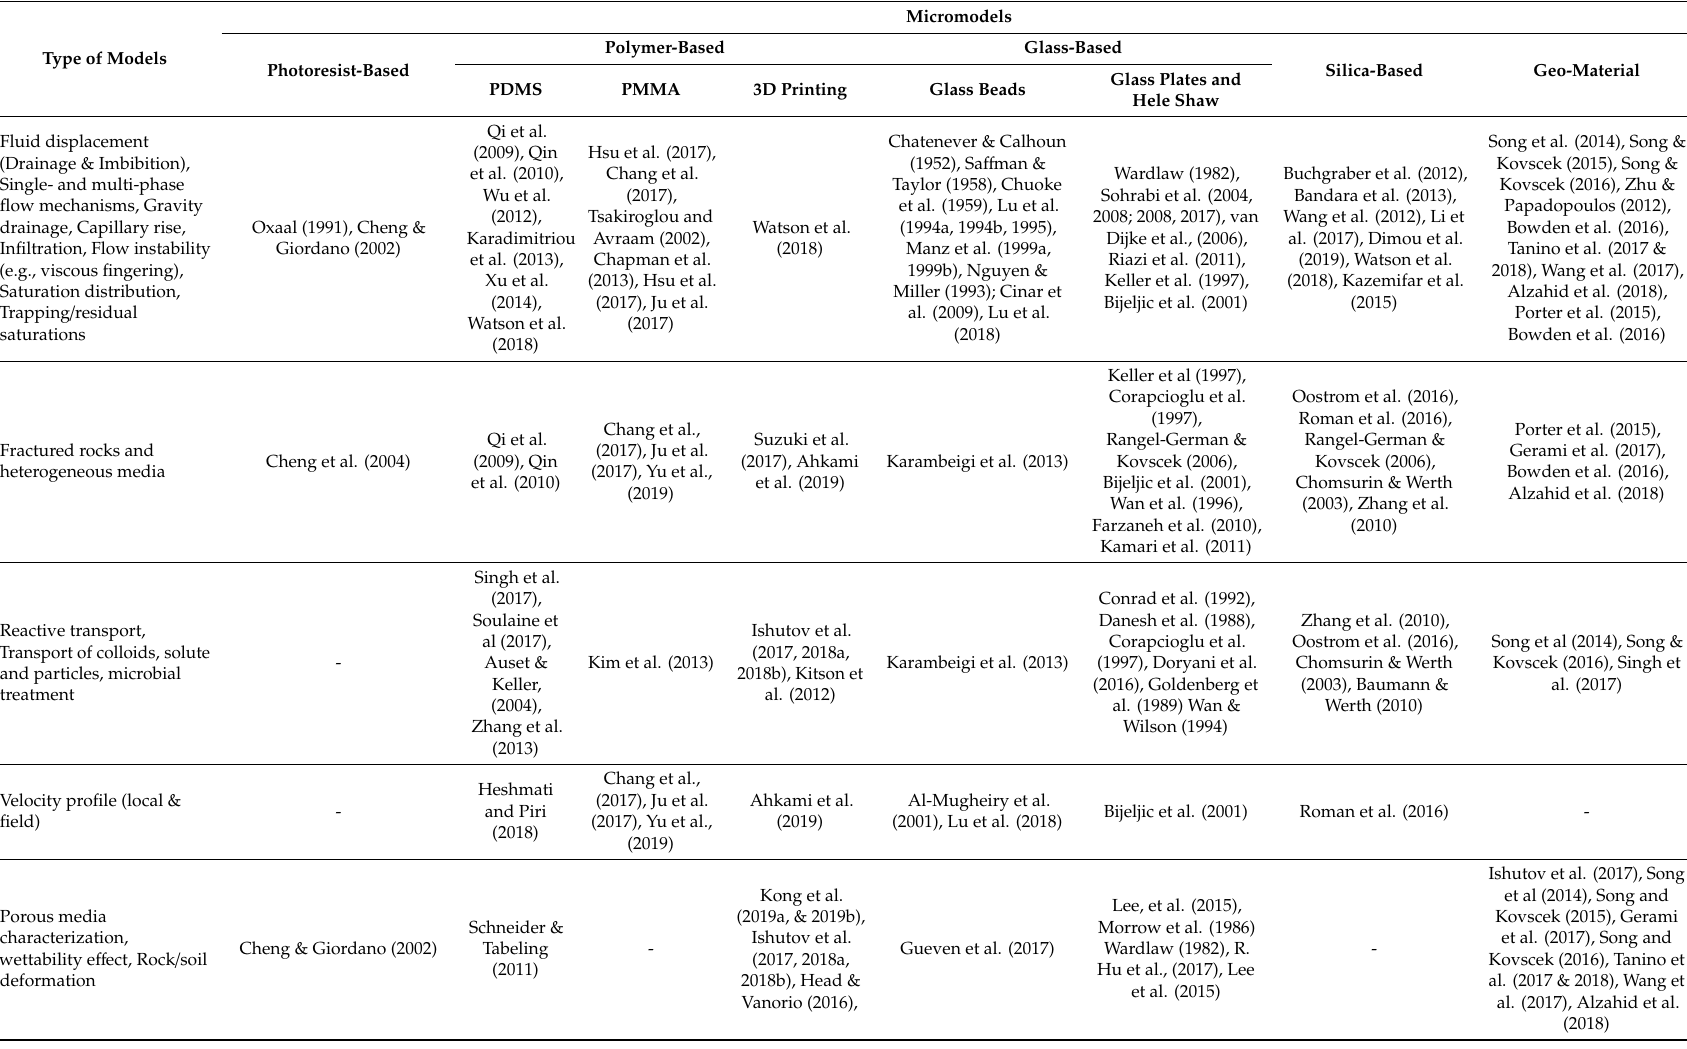
Table 3. Summary of di ff erent applications of micromodels and imaging technique in geoscience and geo-energy engineering reported in this